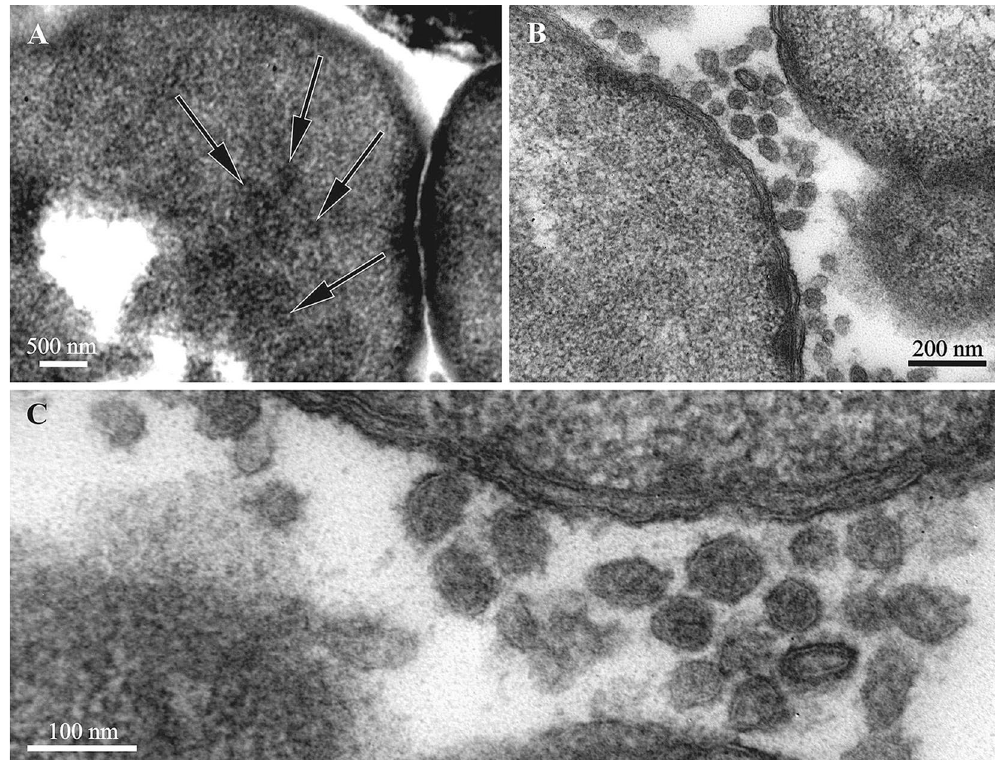
Figure 6. Virus-like particles inside (arrows) ( A ) and outside ( B , C ) of symbiotic bacteria in the funicular bodies of Bugula neritina . A, bacteria of ‘type II’. ( B , C ) VLP between ‘type III’ bacteria.